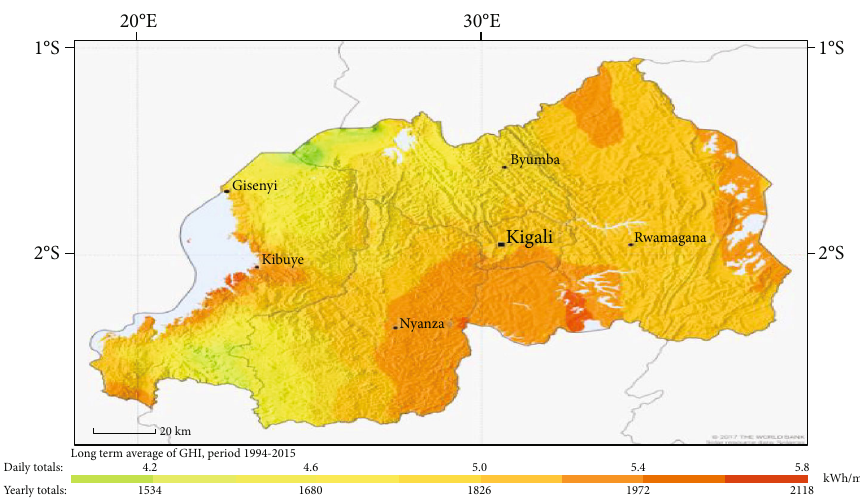
Figure 11: Global horizontal irradiation for Rwanda [49, 51]. Table 2: Solar energy existing projects in Rwanda.